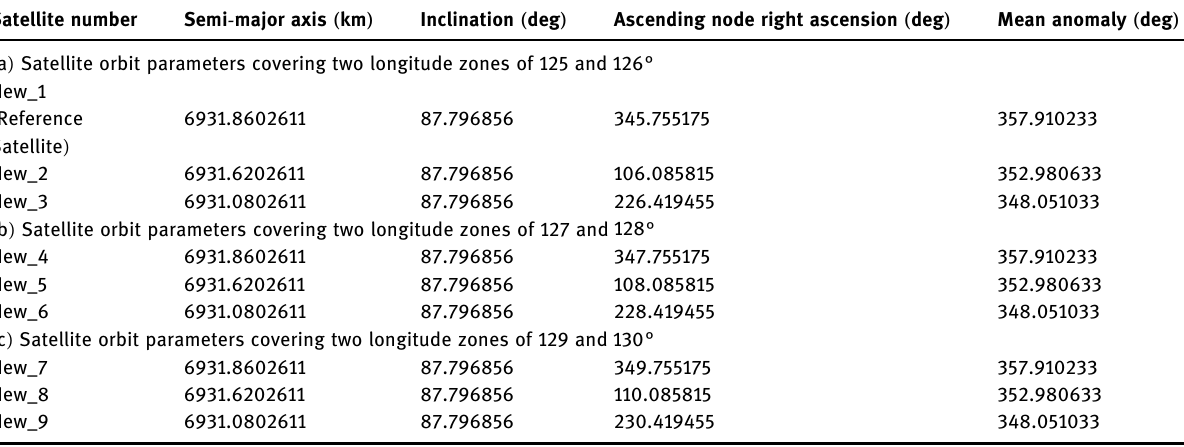
Table 1: Satellite orbit parameters covering two longitude zones Satellite